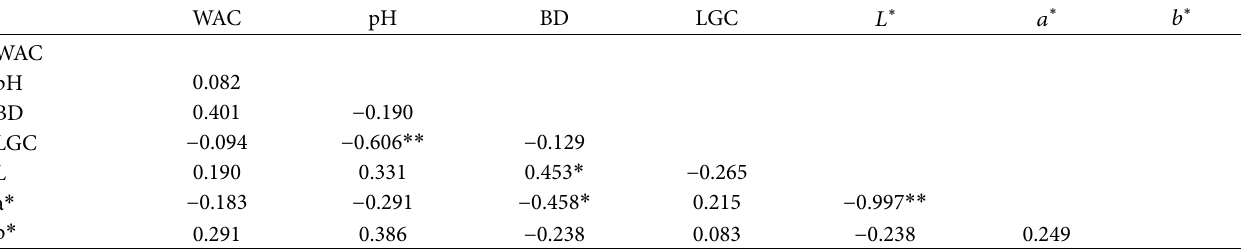
Table 5: Pearson correlation matrices between functional properties and physicochemical properties of NSP flour samples.